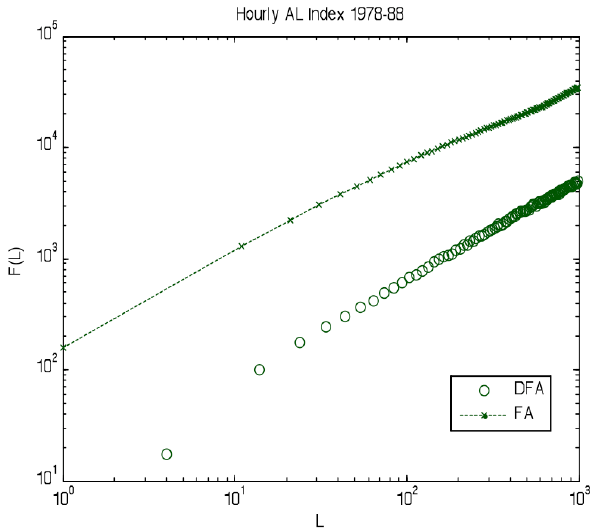
Fig. 5. Fluctuation and detrended fluctuation analysis of 1-h aver- aged AL index data for 1978–1988. The function F(L) shows a break in the scaling near 300min.